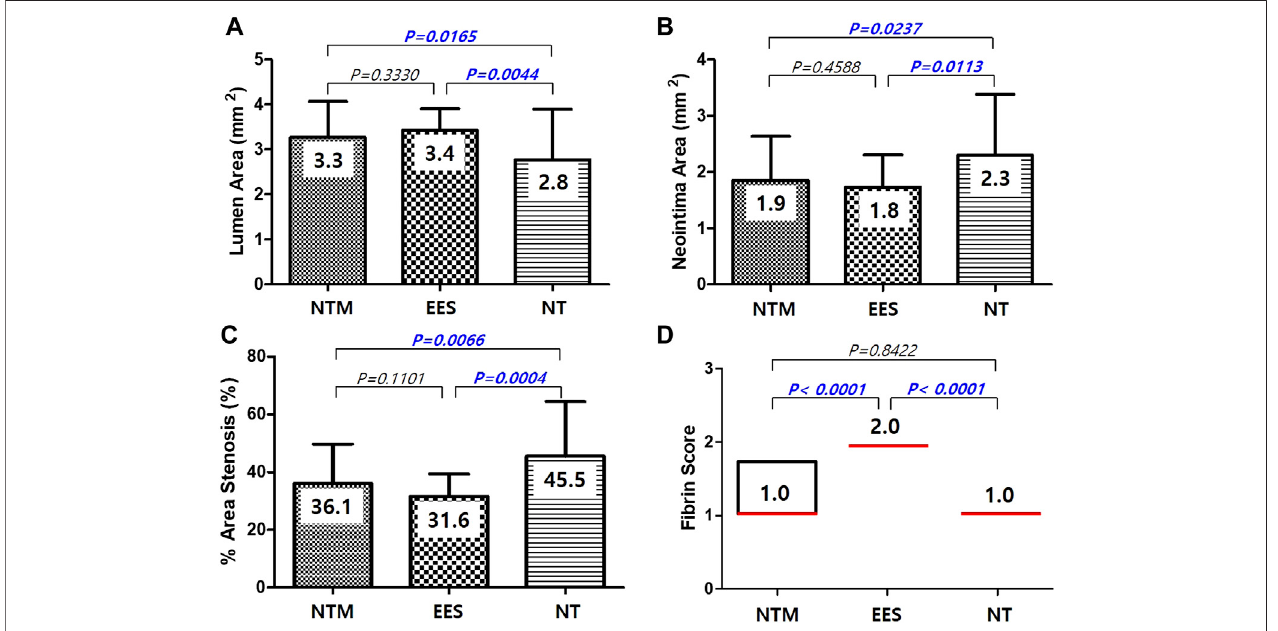
FIGURE 6 | Lumen area (A) , neointima area (B) , percent area stenosis (C) , and fi brin score (D) among NTM, EES, and NT. NTM, TiO 2 fi lm – coated stent with mycophenolic acid; EES, everolimus-eluting stent with biodegradable polymer; NT, TiO 2 fi lm – coated stent.